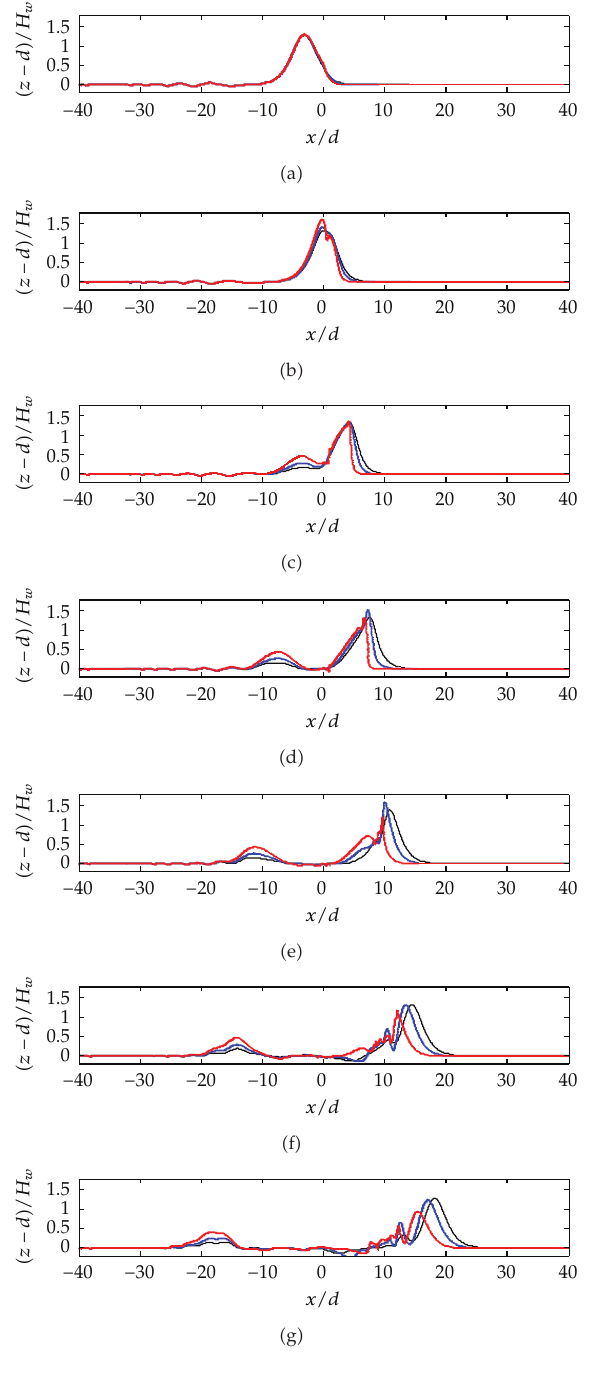
Figure 4: The e ff ect of breakwater height on wave transformation for h (cid:7) 2 . 0m black curve, h (cid:7) 3 . 0m blue curve, and h (cid:7) 4 . 0m red